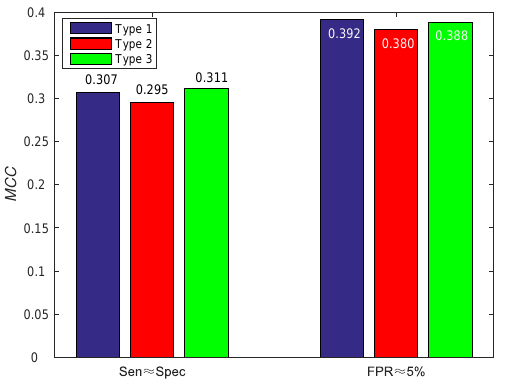
Figure 5. Results for different score functions on PDNA-543. Type 1, 2 and 3 represent Equations (16)–(18), respectively.